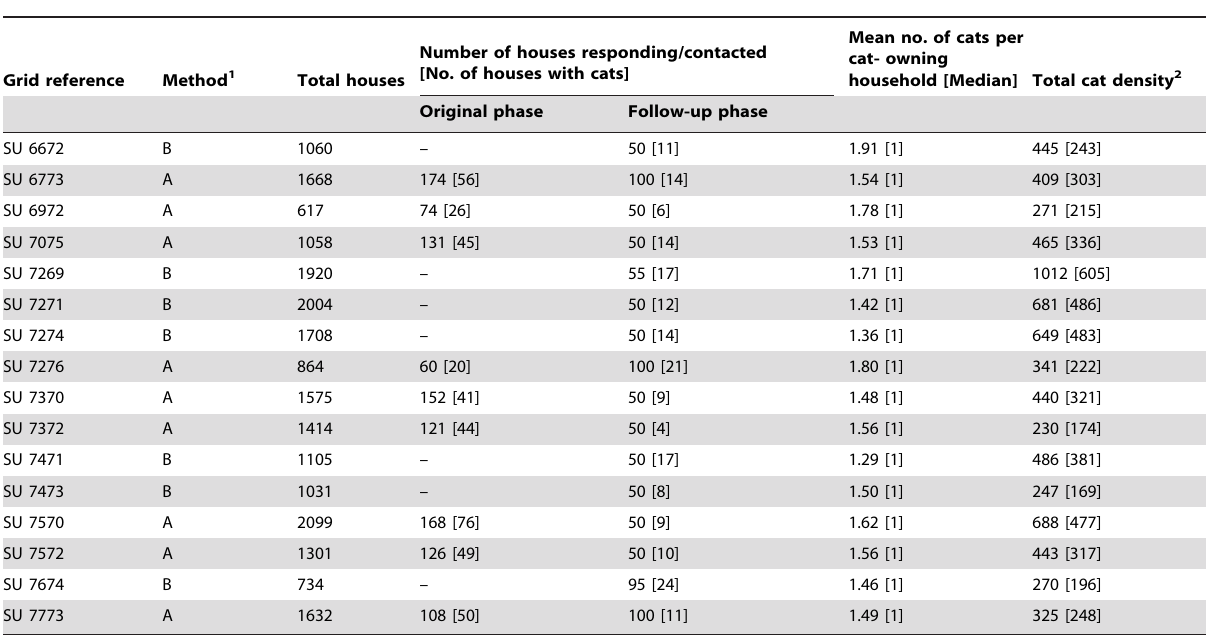
Table 1. Estimated cat density in 16 1-km 2 squares in